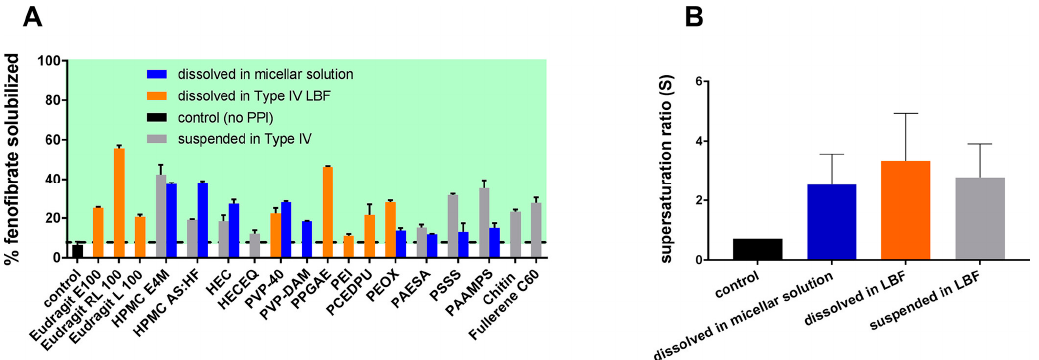
Figure 4. In vitro evaluation of the impact of the presence of PPIs predispersed in different media on fenofibrate solubilization and supersaturation after dispersion (15 min) and digestion (60 min) in a Type IV formulation at 85% saturated solubility [mean ± SD ( n ≥ 3)]. Panel A : Shows the % drug solubilized over the period of formulation dispersion and digestion, calculated by dividing the AUC of the concentration versus time profile obtained in the in vitro test by the AUC of the maximum apparent equilibrium solubility over the same time period (representing 100% solubilized). The horizontal black dotted line represents the extent of drug solubilization obtained from the formulation in the absence of polymer (also shown as the black (control) bar). Data above the line represent formulations where polymer addition leads to lower drug precipitation during formulation dispersion and digestion (and therefore greater drug solubilization). The green panel highlights the area where the % solubilized fenofibrate exceeds that of the formulation without polymer (control). Panel B : Mean supersaturation ratio (S) obtained over the period of dispersion and digestion of the formulations; data grouped for polymers with di ff erent solubility profiles in the LBF. Reprinted from [32] with permission (ACS publications 2018).